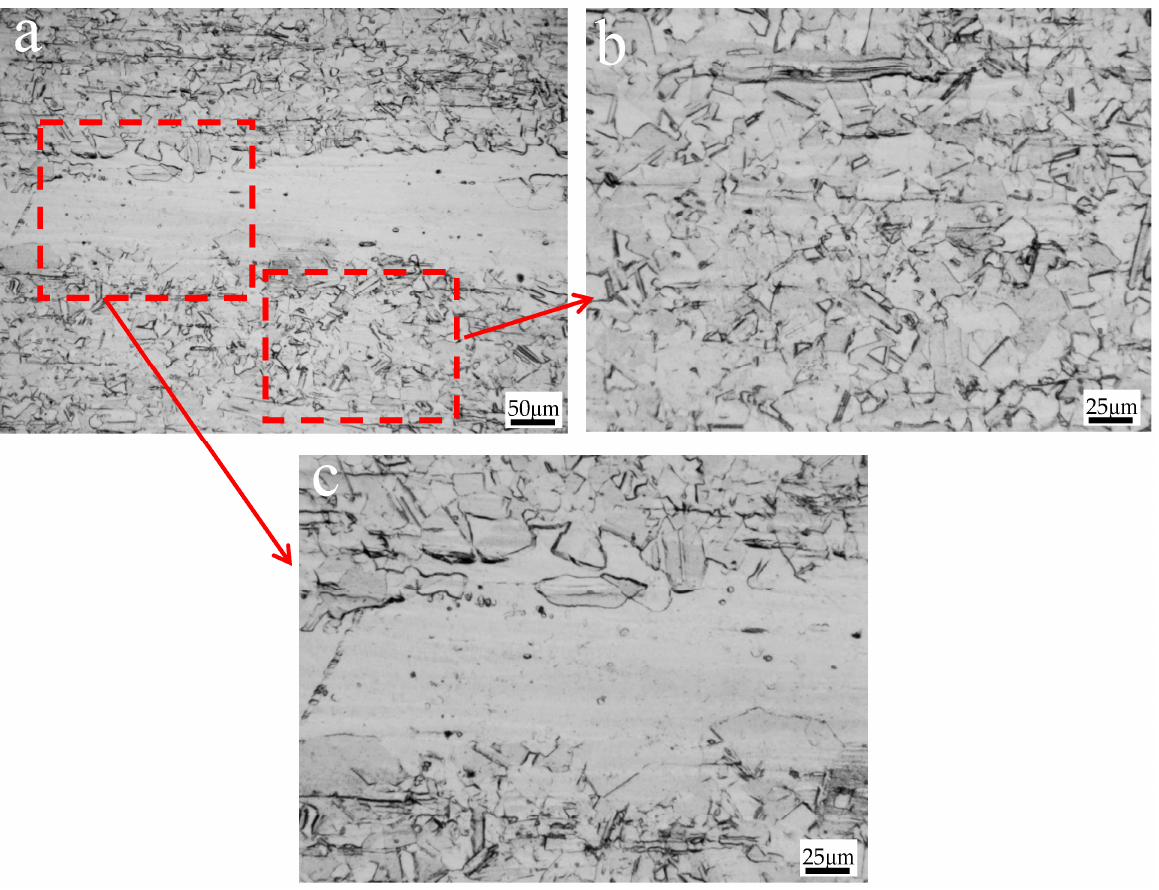
Figure 2. Metallographic photographs of shear band ( a , c ) and surrounding recrystallized microstructures ( b ) of 301ASS-1.1Cu.